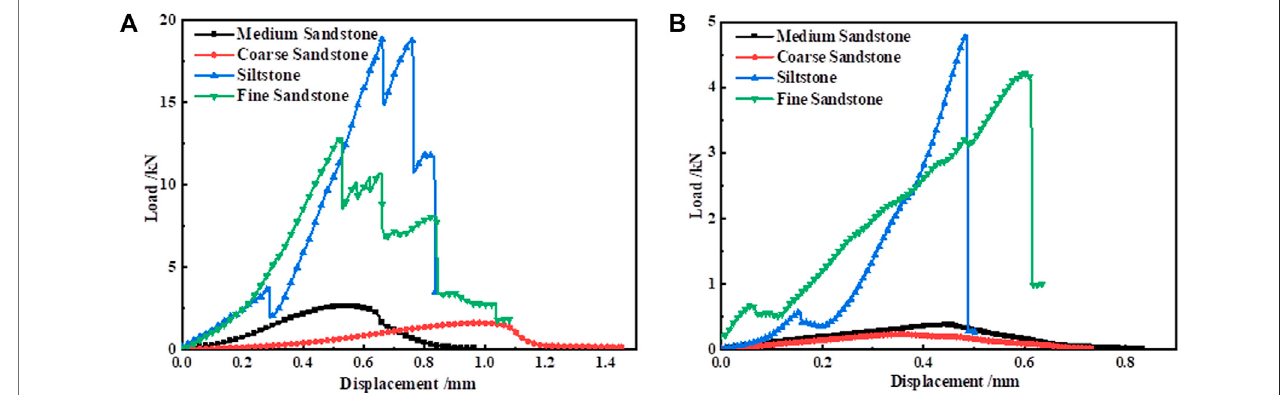
FIGURE6| Distribution ofload,damage andsignalstrength fortypical sandstonewithdifferentgrainsizesunderuniaxialcompression (A) medium sandstone, (B) coarse sandstone, (C) siltstone, and (D) fi ne sandstone.